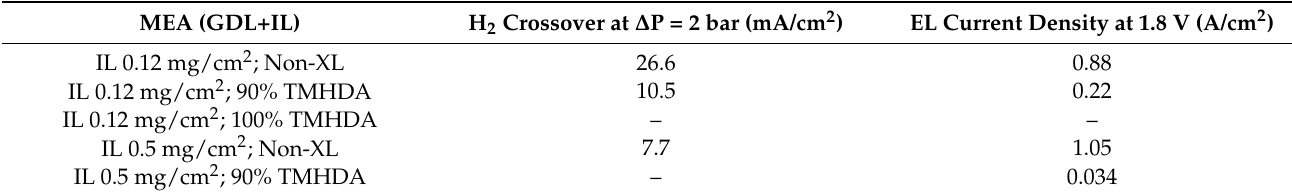
Table 2. The hydrogen crossover (expressed as the limiting current density in the crossover experiment, in mA/cm 2 ) and electrolyzer cell performance (current density at 1.8 V) are tabulated for different GDE+IL configurations. MEA (GDL+IL) H 2 Crossover at ∆ P = 2 bar (mA/cm 2 ) EL Current Density at 1.8 V (A/cm 2 ) IL 0.12 mg/cm 2 ; Non-XL 26.6 0.88 IL 0.12 mg/cm 2 ; 90% TMHDA 10.5 0.22 IL 0.12 mg/cm 2 ; 100% TMHDA – – IL 0.5 mg/cm 2 ; Non-XL 7.7 1.05 IL 0.5 mg/cm 2 ; 90% TMHDA